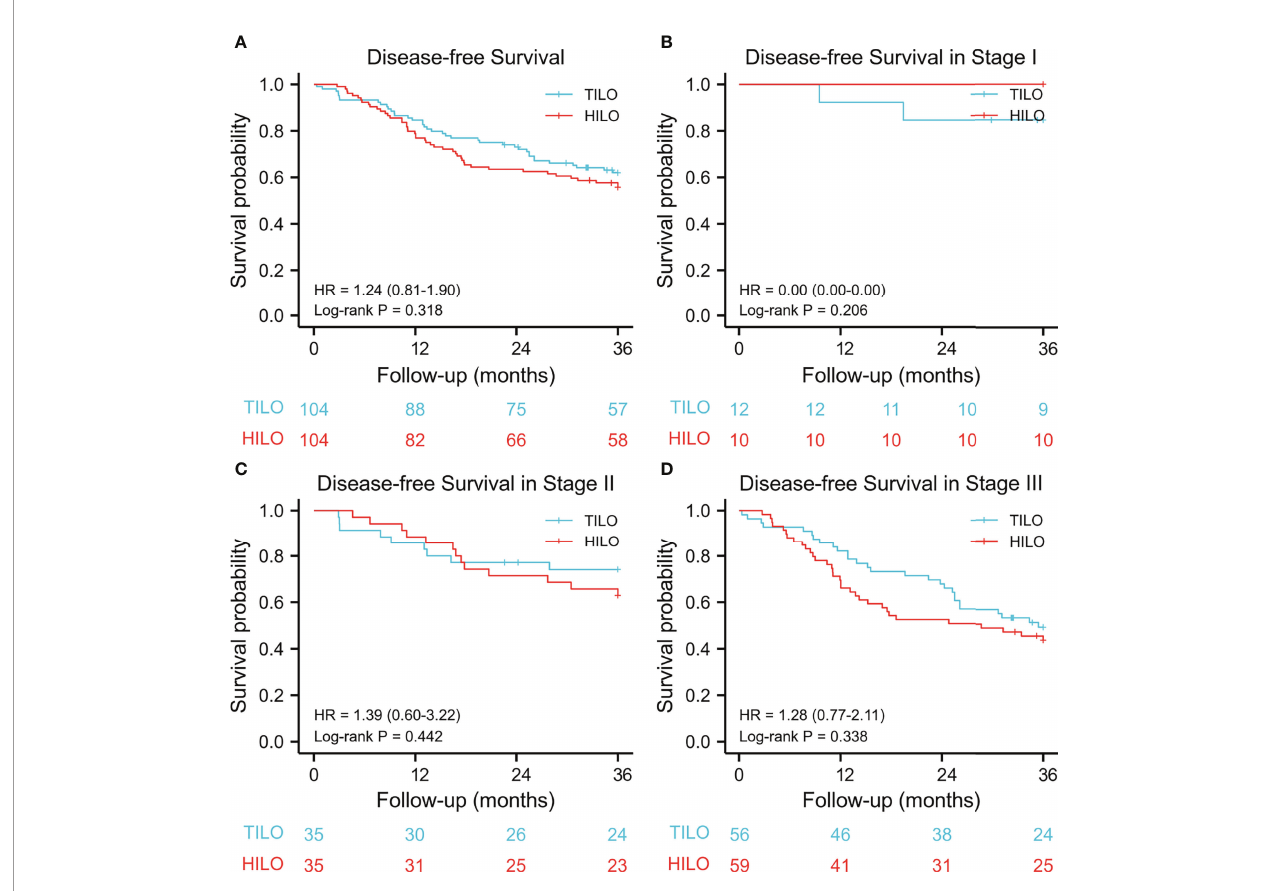
FIGURE 4 | Kaplan – Meier disease-free survival curves strati fi ed by clinical stage. (A) the entire cohort, (B) stage I; (C) stage II, (D) stage